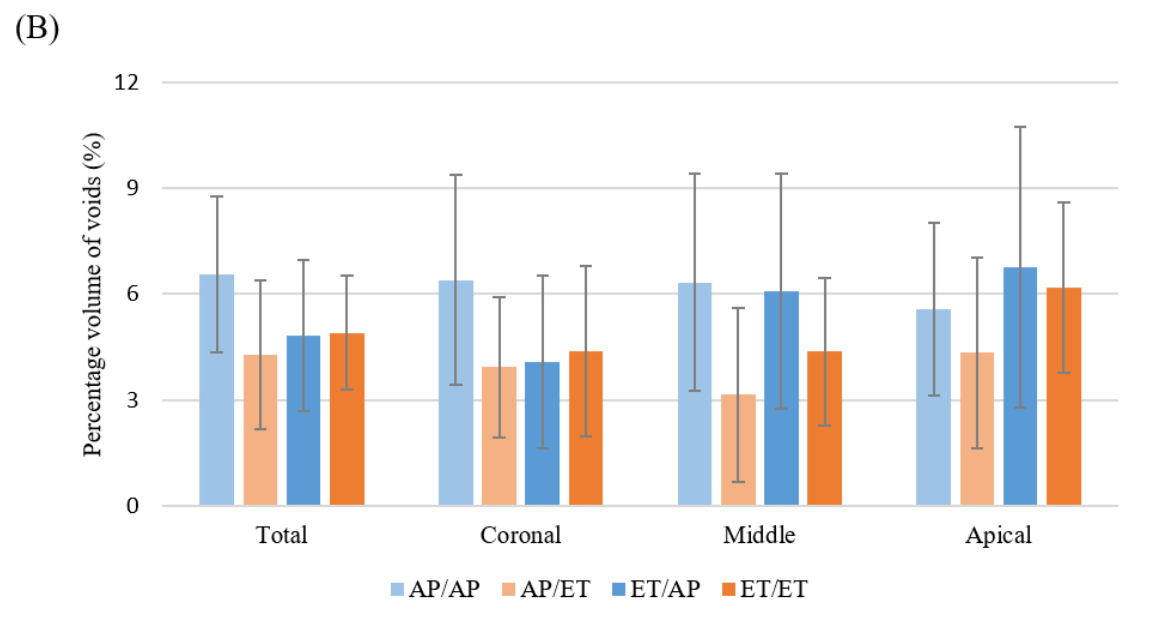
Figure 1. ( A ) Representative three-dimensional reconstructions after re-obturation. Filling materials (GP and sealer) are represented in blue, and voids are represented in red. ( a ) AP/AP; ( b ) AP/ET; ( c ) ET/AP; ( d ) ET/ET. ( B ) Percentage volume of voids (Mean ± standard deviation) after re-obturation in 4 groups in the whole canal and in the different thirds. There are no significant differences between the groups in the same portions ( p > 0.05). Table 2. Percentage volumes of voids (mean ± standard deviation) after re-obturation according to the first used sealer in the whole canal and in each third.